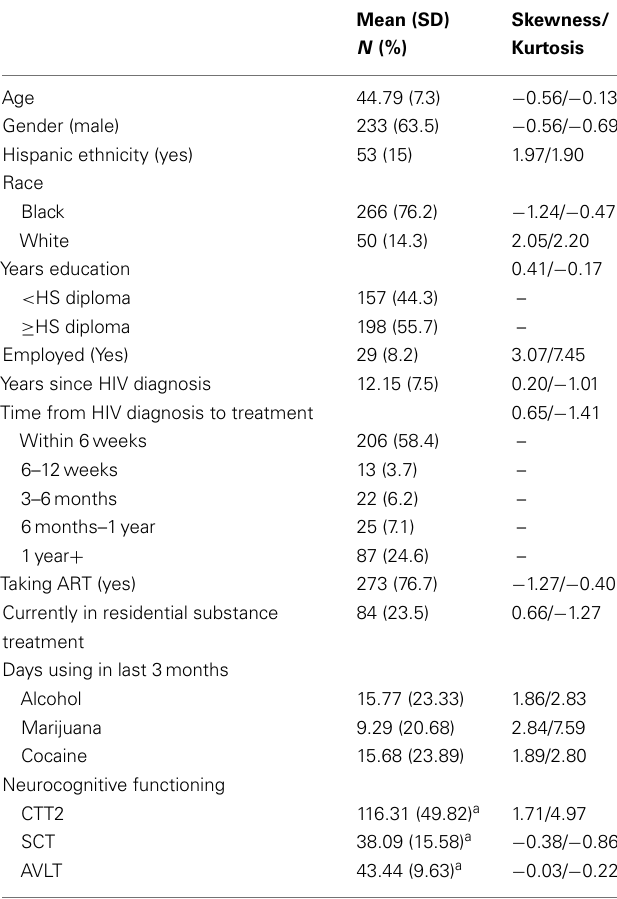
Table 1 | Sociodemographic characteristics of participants at baseline ( N = 370) .